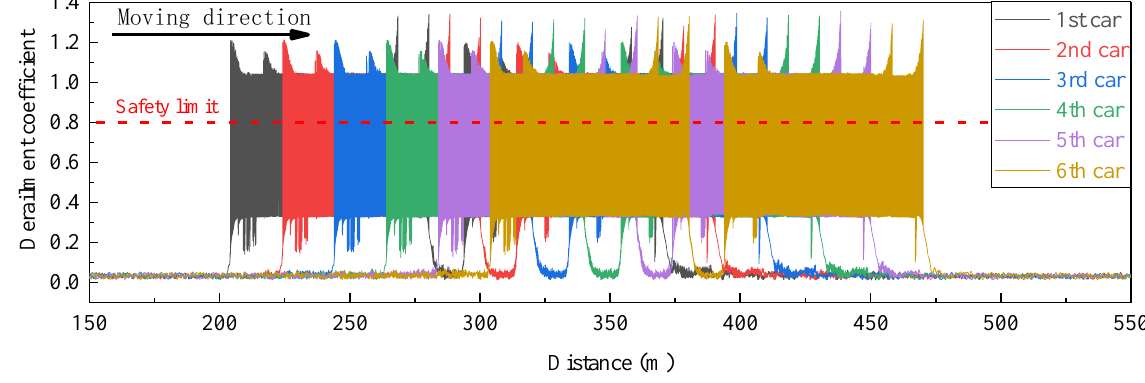
Figure 13. Derailment coefficient time-domain diagram.